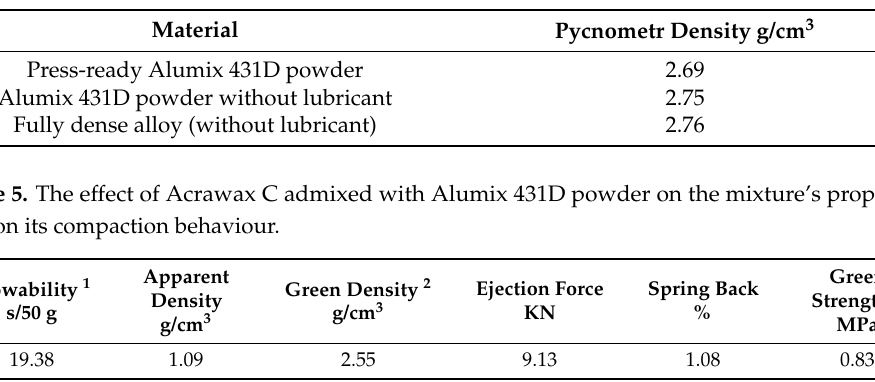
Table 4. Pycnometer densities of Alumix 431D powder and the fully dense alloy of the same composition.